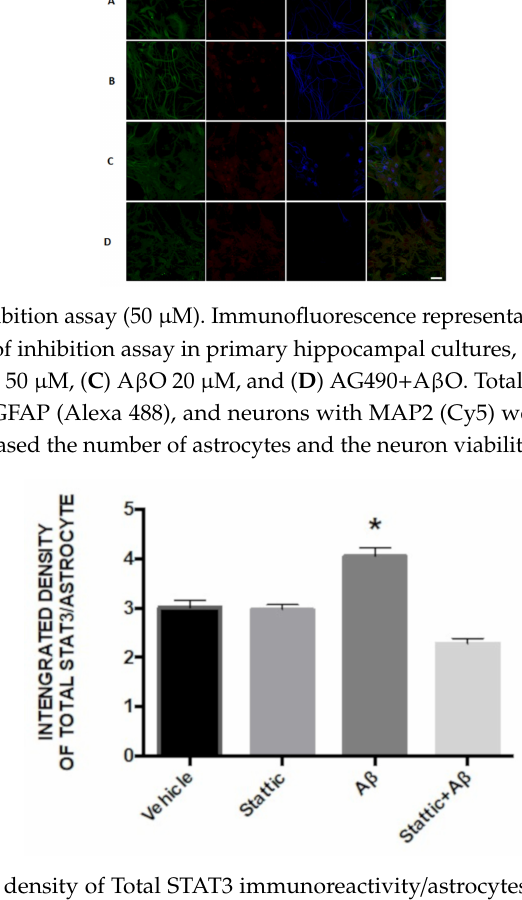
Figure A3. Integrated density of Total STAT3 immunoreactivity / astrocytes. Data are means ± SEM ( n = 4, 4 astrocytes). One-way ANOVA followed by Tukey’s post hoc test (* p <